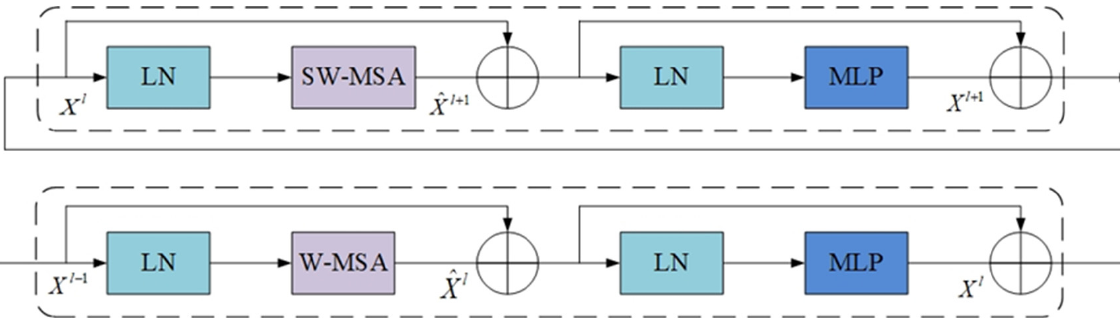
Figure 9. Swin Transformer module network structure